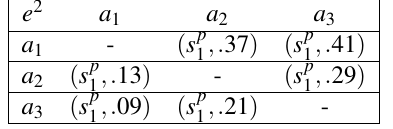
Table 10. Aggregated linguistic preference indexes for e 2 .